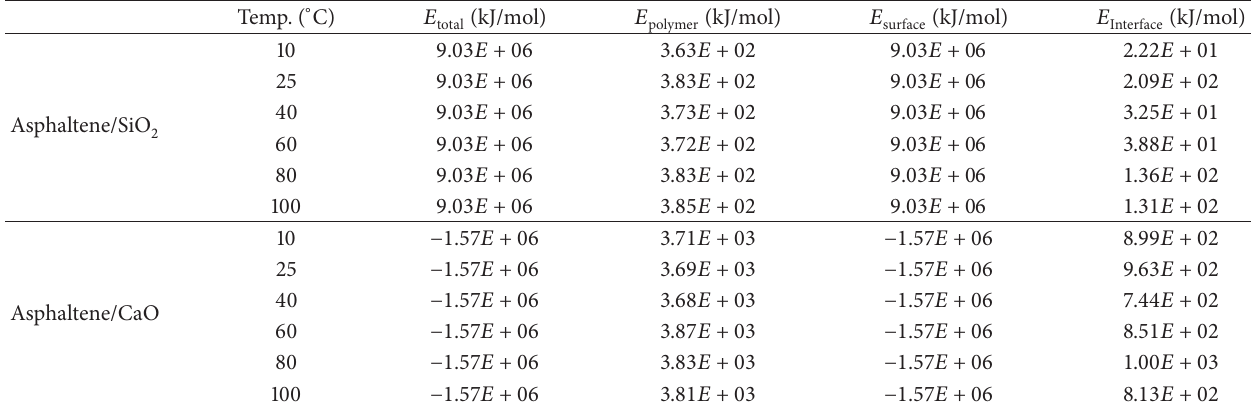
Figure 12: The interface configuration of asphaltene/MgO (10–40 ∘ C). Table 1: Asphaltene/SiO 2 and